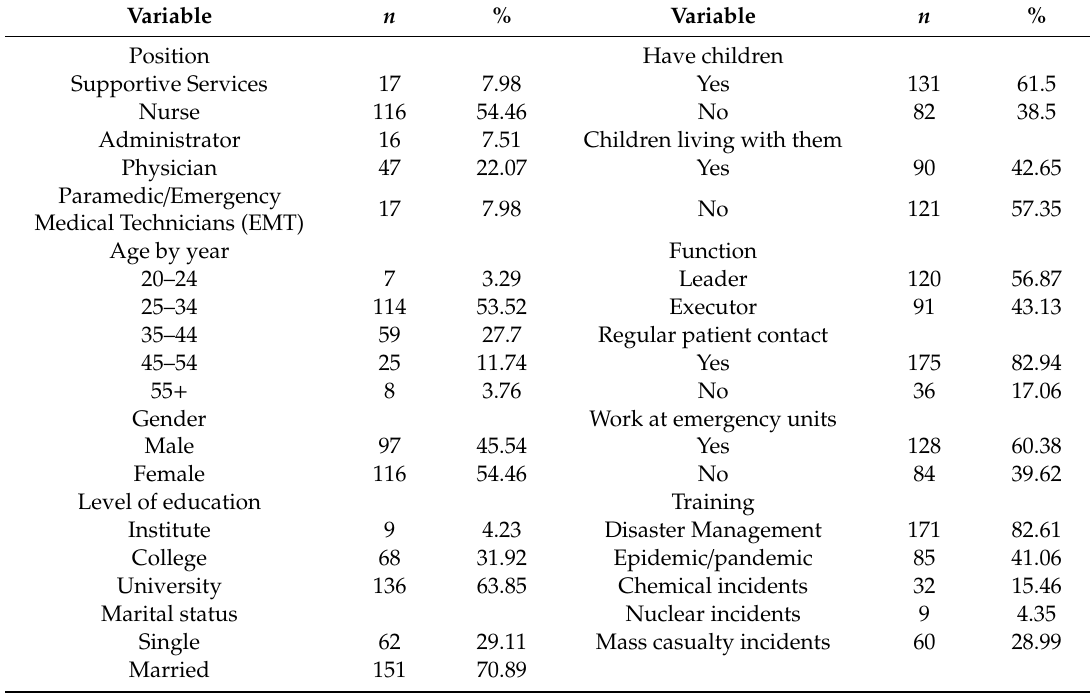
Table 1. Demographic data ( n =